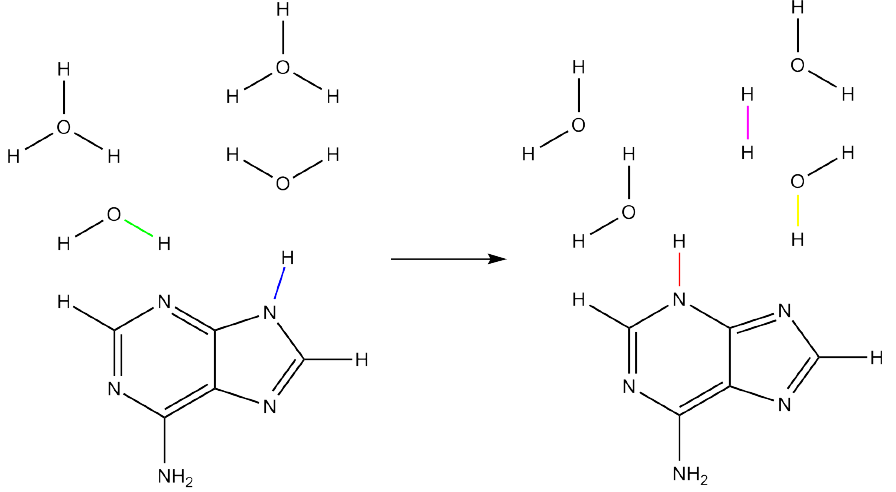
Figure 3. Reaction mechanism which leads to the formation of the adenine isomer 1d which was exclusively observed under cathodic conditions. The oxidation state of the adenine moiety stays the same, but a H 2 molecule is